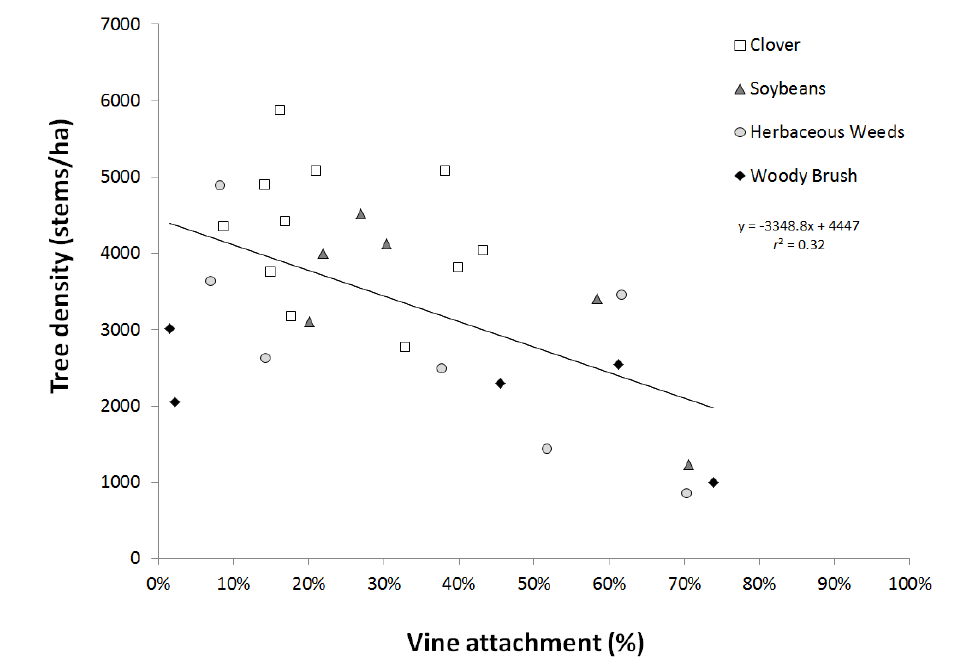
Figure 5. Relationship between tree density (including Elaeagnus umbellata ) and vine attachment (%) on those trees. Tree density was negatively correlated with vine attachment ( r 2 = 0.32). Land Cover Types (LCT) are distinguished by unique symbols for each